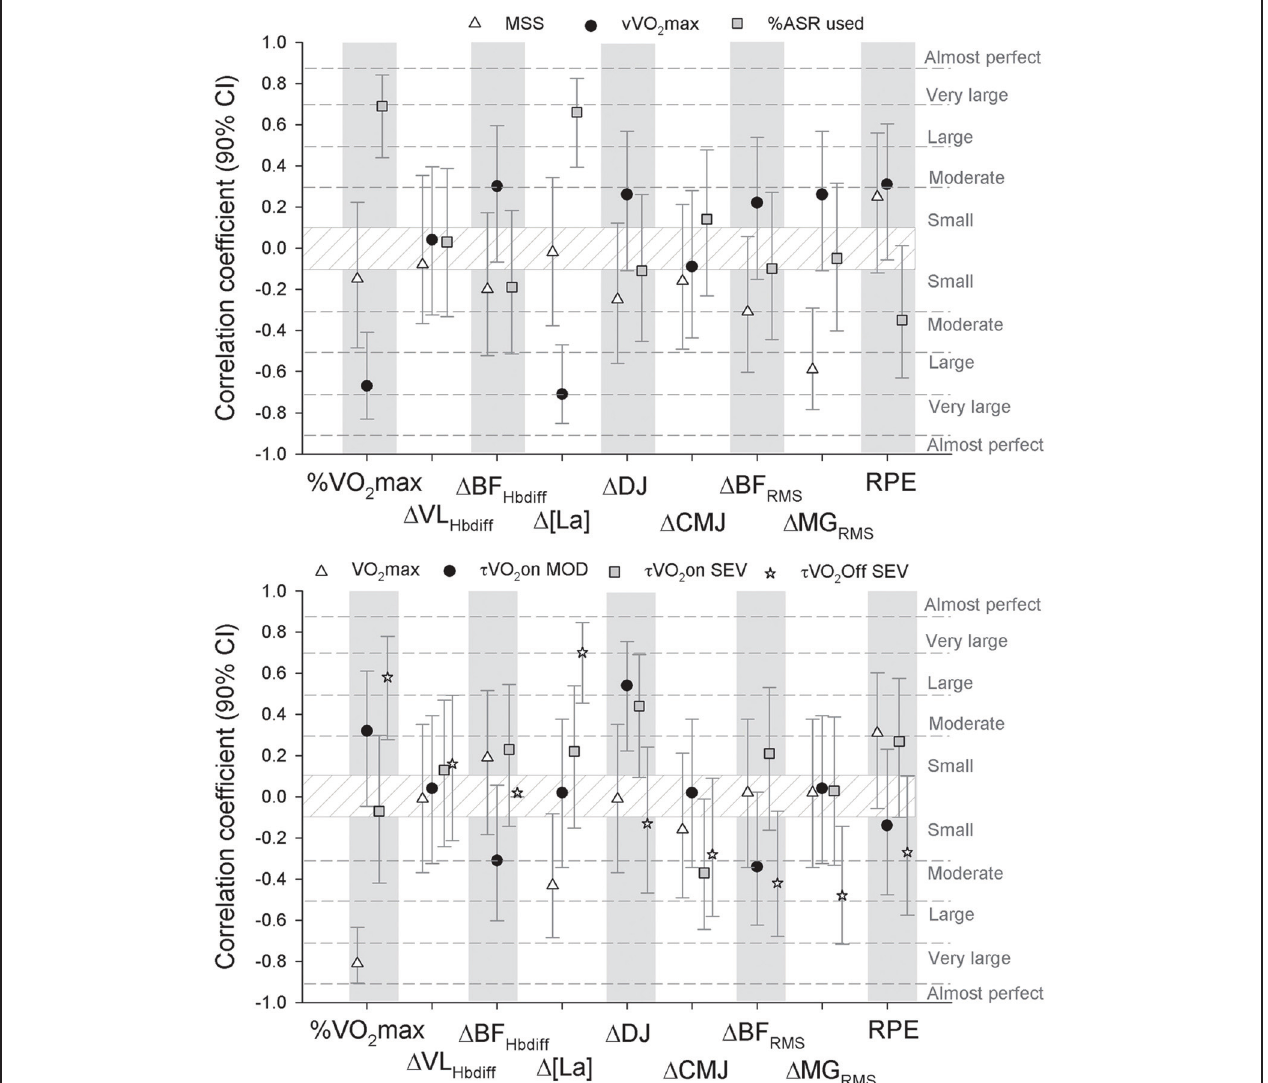
FIGURE 3 | Correlation coefficients (with confidence intervals) for the relationships between physiological, perceptual and neuromuscular responses to the two first sets of HIT [oxygen uptake expressed as a percentage of maximal oxygen uptake (% ˙ V O 2 max), changes in vastus lateralis ( (cid:2) VL Hbdiff ) and biceps femoris ( (cid:2) BF Hbdiff ) oxygenation, changes in blood lactate ( (cid:2) [La]), changes in drop jump and counter movement jump height ( (cid:2) DJ and (cid:2) CMJ), changes in muscle activity of the biceps femoris ( (cid:2) BF RMS ), medial gastrocnemius ( (cid:2) MG RMS ), and rate of perceived exertion (RPE)] and either locomotor profile [upper panel,